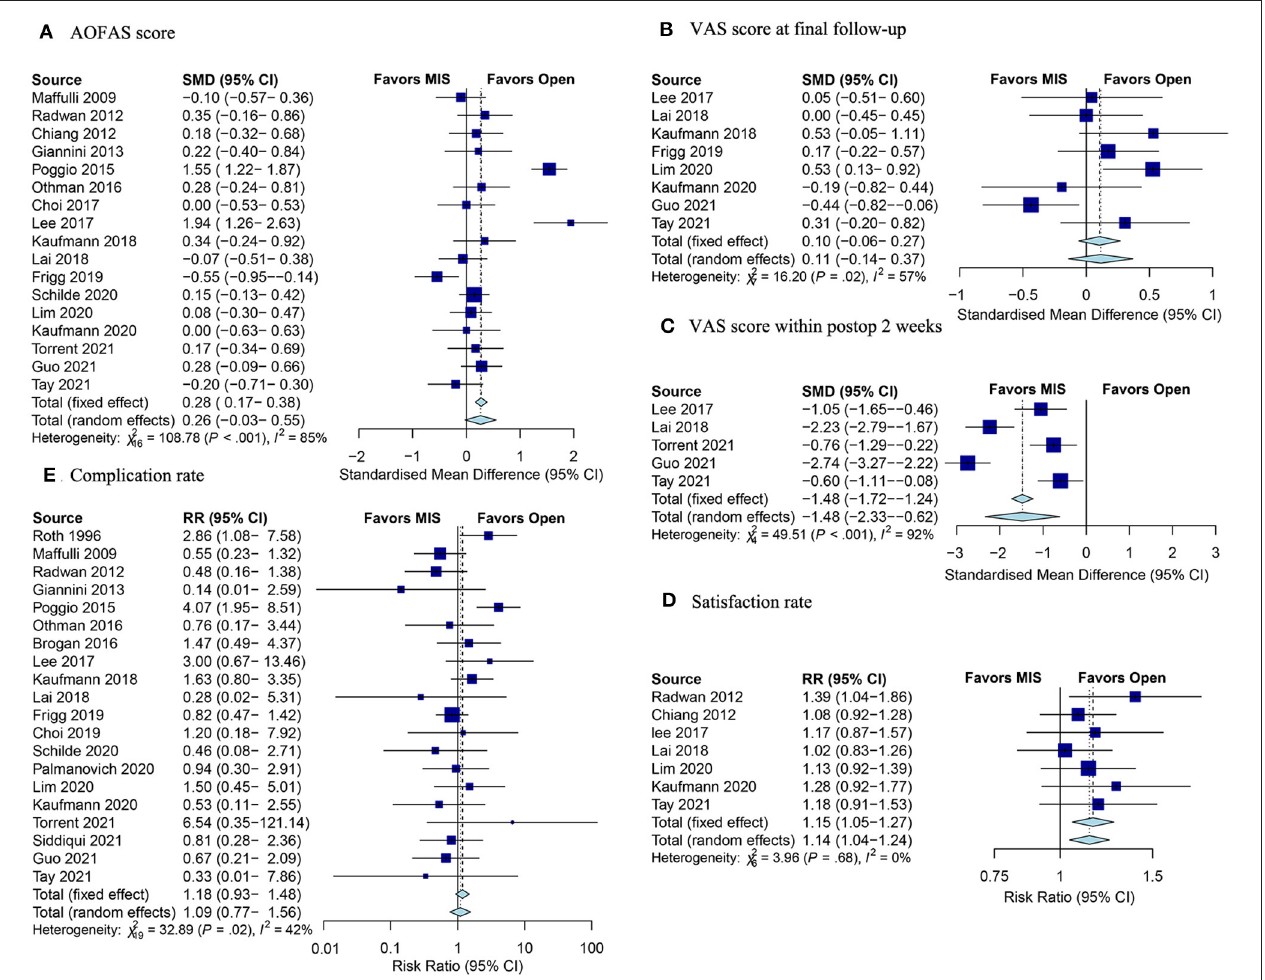
FIGURE 4 | Forest plots of clinical outcomes. (A) SMD for the AOFAS score improvement between the MIS and open groups; (B) VAS score at the final follow-up; (C) VAS score within post-operative 2 weeks; (D) satisfaction rate; and (E) complication rate. SMD, standardized mean difference; AOFAS, the American Orthopedic Foot and Ankle Society; MIS, minimally invasive surgery; VAS, visual analog scale; postop,